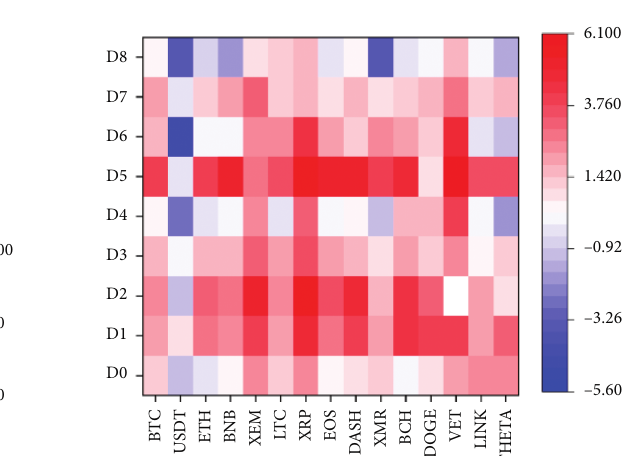
Figure 9: Causality test under D8.